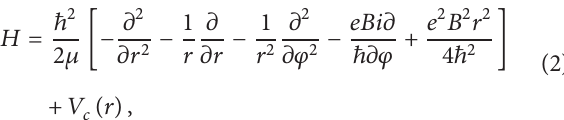
Figure 1: Schematic view of a parabolic confinement potential for a two-dimensional QD.